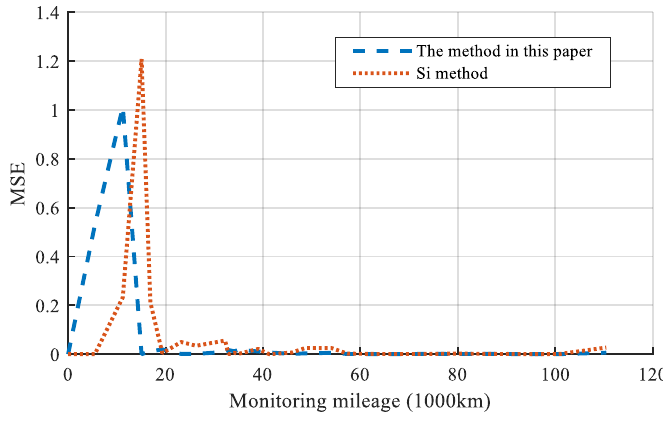
Figure 19. MSE of two methods.